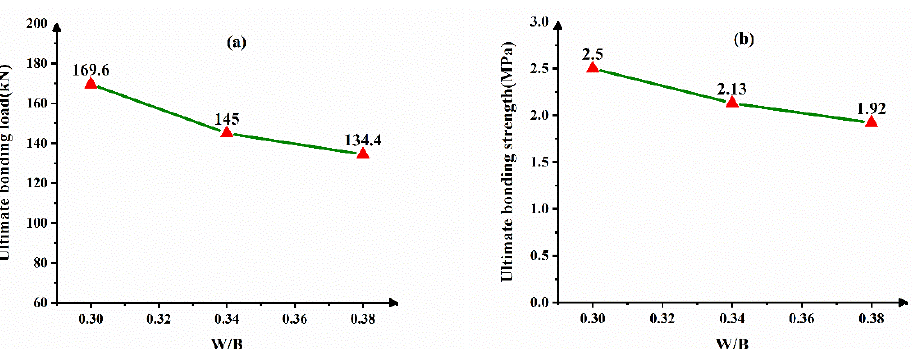
Figure 9. Dependence of W/B on the interface bonding behavior ( a ) ultimate bonding load ( b ) ultimate bonding strength.